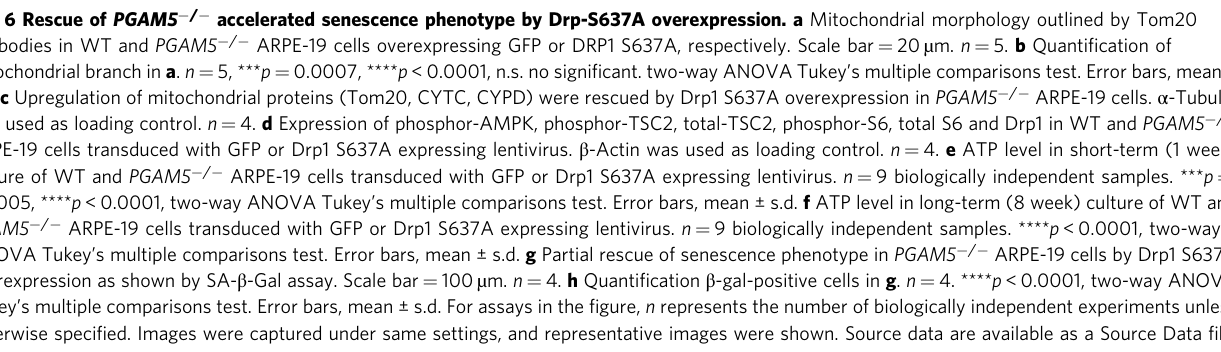
Fig. 6 Rescue of PGAM5 − / − accelerated senescence phenotype by Drp-S637A overexpression. a Mitochondrial morphology outlined by Tom20 antibodies in WT and PGAM5 − / − ARPE-19 cells overexpressing GFP or DRP1 S637A, respectively. Scale bar = 20 µ m. n = 5. b Quanti fi cation